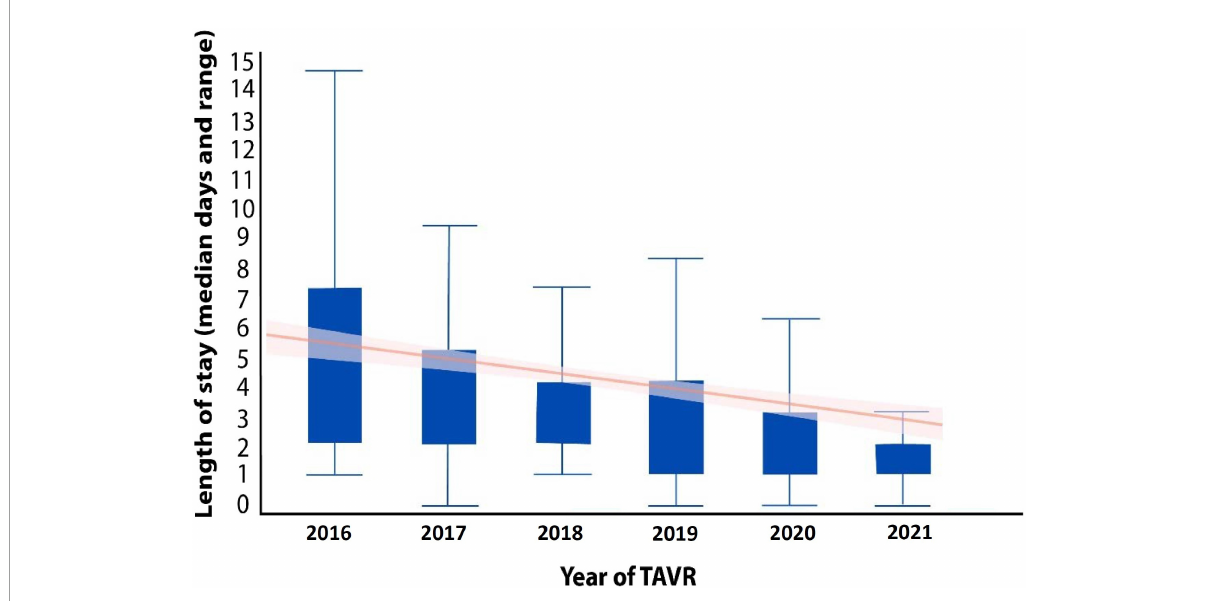
FIGURE6 The median length of hospitalization of TAVR patients from 2016 to